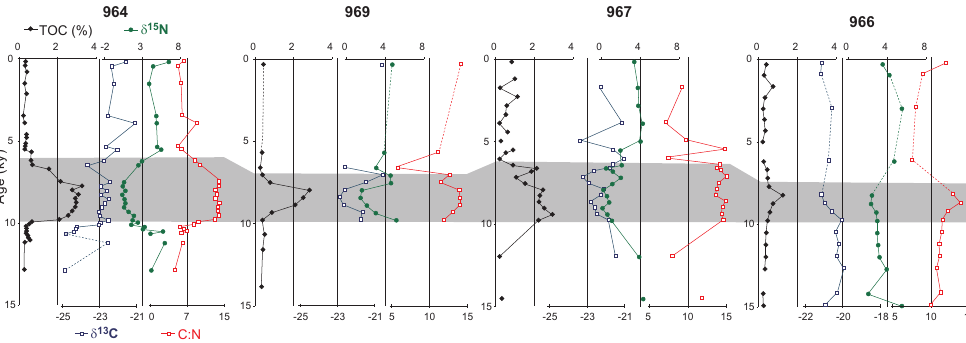
Fig. 7. TOC, C and N ratio, δ 15 N, δ 13 C for S1 at all studied sites. Shaded area corresponds to organic enriched sediments.